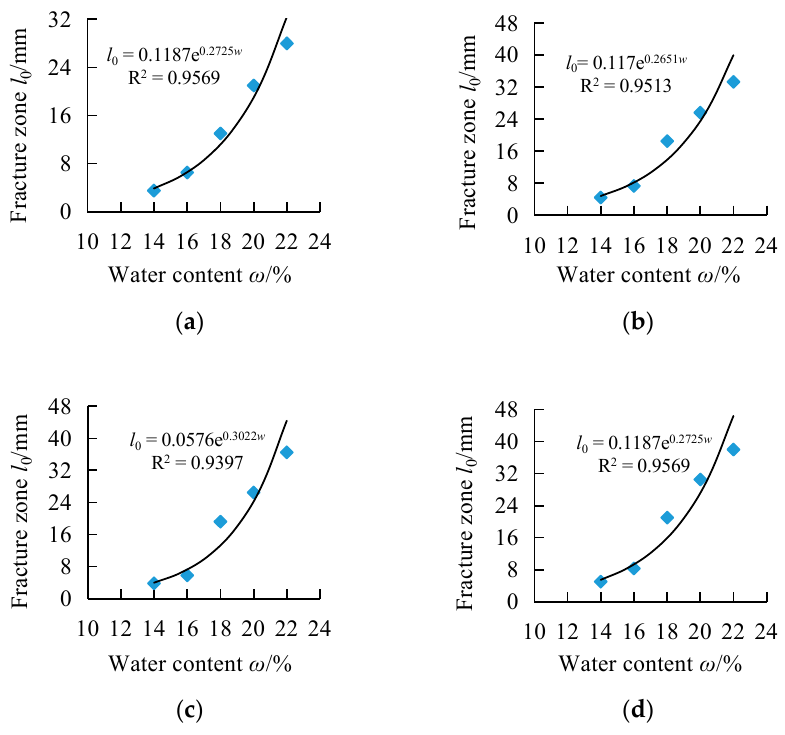
Figure 16. Length of fracture zone with water contents: ( a ) ρ d = 1.28 g/cm 3 ; ( b ) ρ d = 1.37 g/cm 3 ; ( c ) ρ d = 1.46 g/cm 3 ; ( d ) ρ d = 1.53 g/cm 3 .